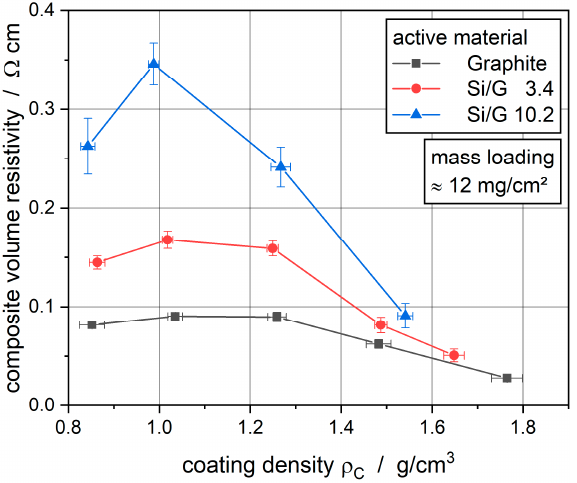
Figure 6. Composite volume resistivity of the electrodes with different coating densities.